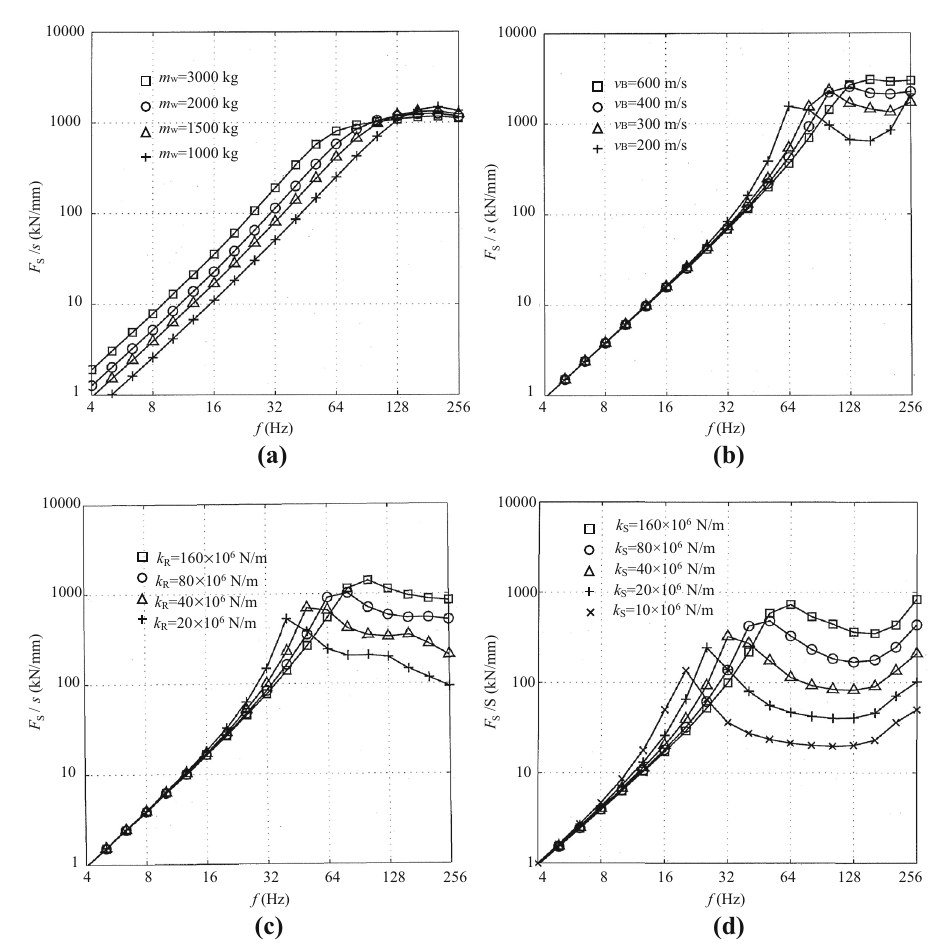
Fig. 4 Transfer function F S / s between the irregularities s and the force F S on the soil: a for different wheelset masses (rail pad k R = 300 9 10 6 N/m, ballast v B = 400 m/s and soil v S = 200 m/s); b for different ballast (rail pad k R = ? and soil v S = 500 m/s); c for different rail pads (ballast v B = 600 m/s and soil v S = 300 m/s); d for different sleeper pads (rail pad k R = 300 9 10 6 N/m, ballast v B = 600 m/s and soil v S = 300